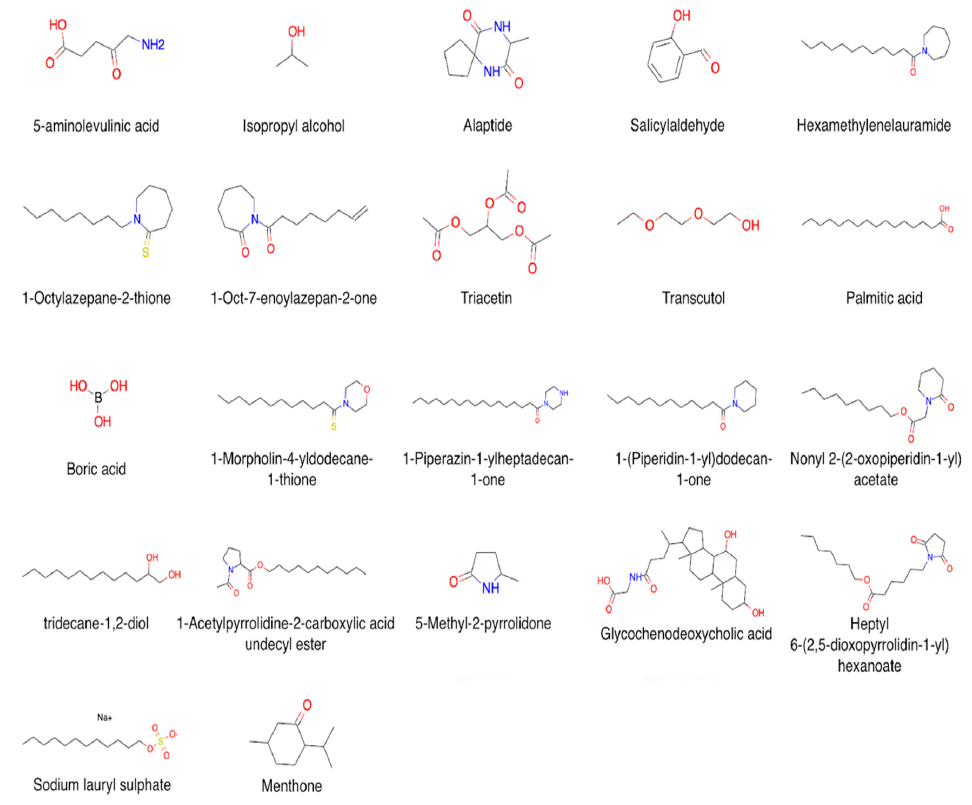
Figure 2. Examples of compound structures in CPE-DB.